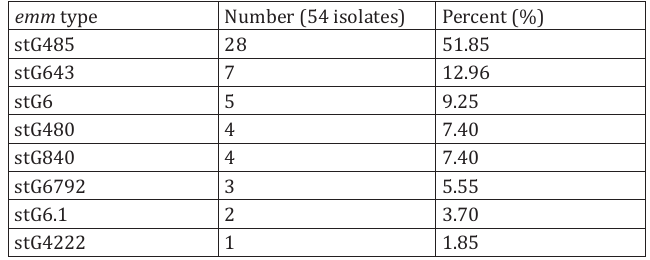
emm types detected in SDSE